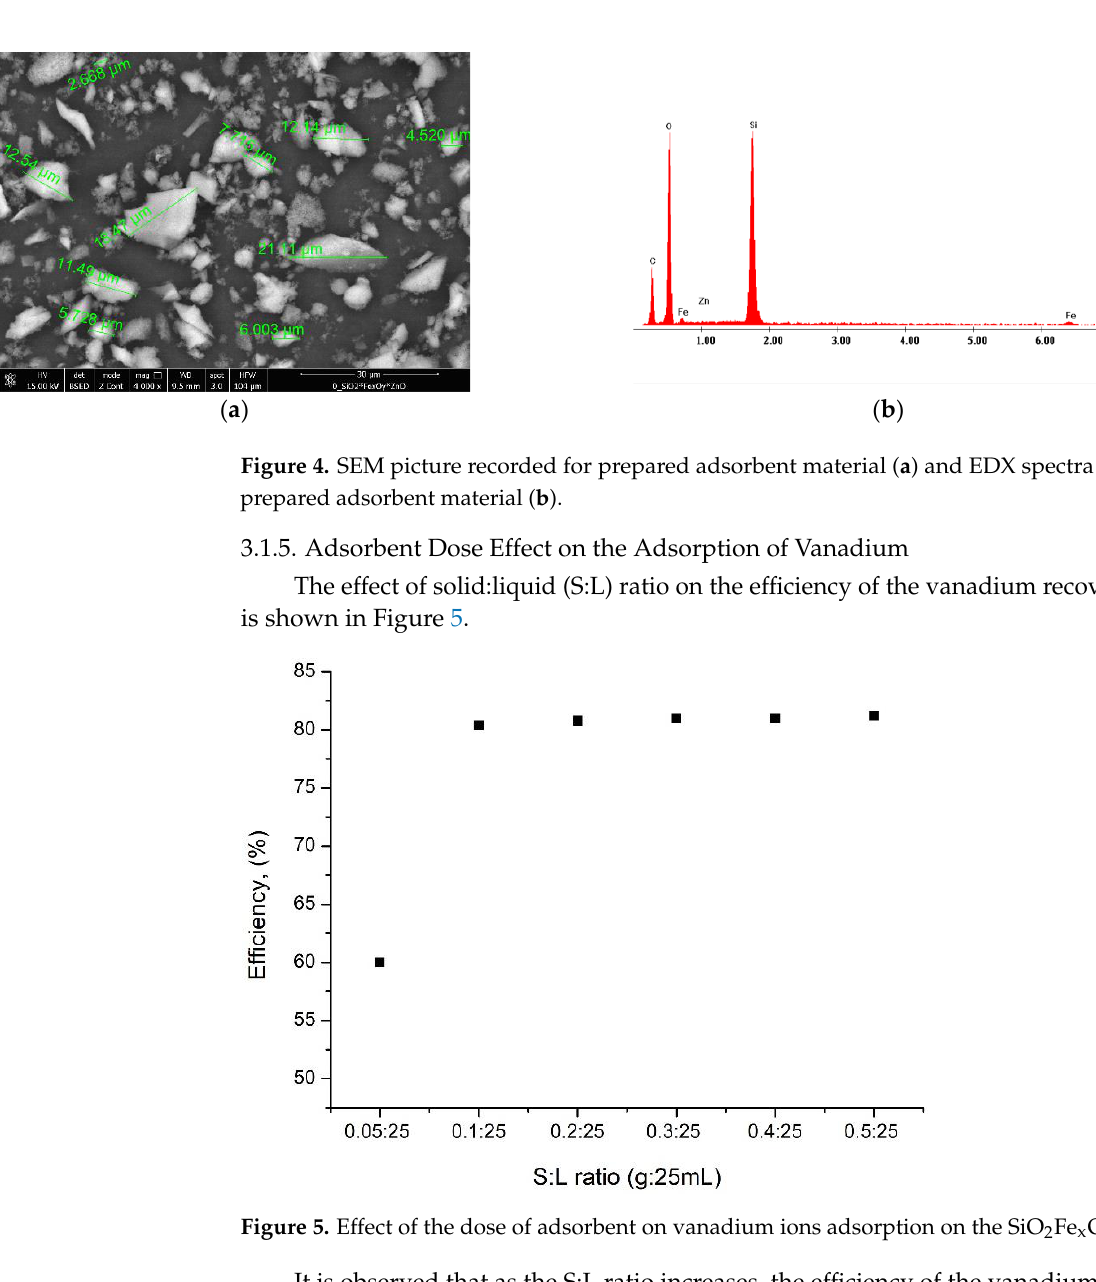
Figure 5. Effect of the dose of adsorbent on vanadium ions adsorption on the SiO 2 Fe x O y material.